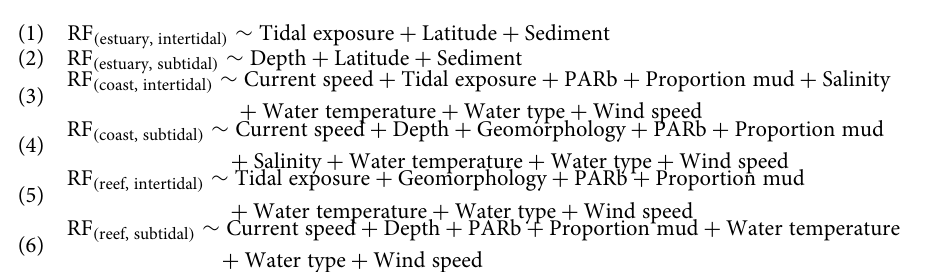
The six RF models were used to generate rasters of seagrass predicted probability across the entire GBRWHA. We created this by predicting each model onto a raster stack of data corresponding to the same predictors included in each model using the raster package in R 82 . Raster data sets within each stack were predicted to the